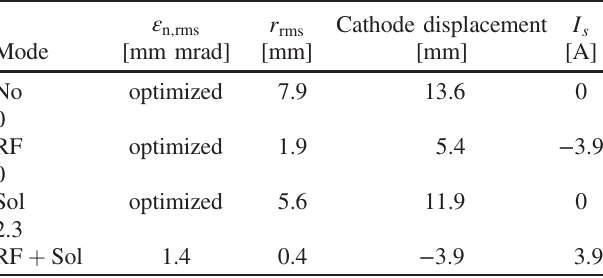
TABLE I. Simulation Results for the tracking of a 250 pC bunch from the SRF